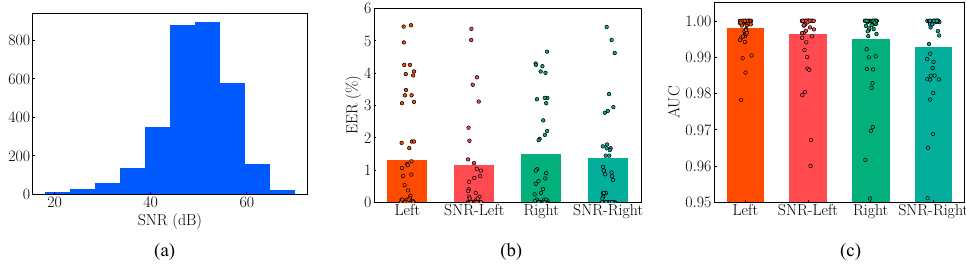
Figure 11. ( a ) Histogram of SNRs. ( b ) EER when signals with SNR less than 30 dB are excluded. ( c ) AUC when signals with SNR less than 30 dB are